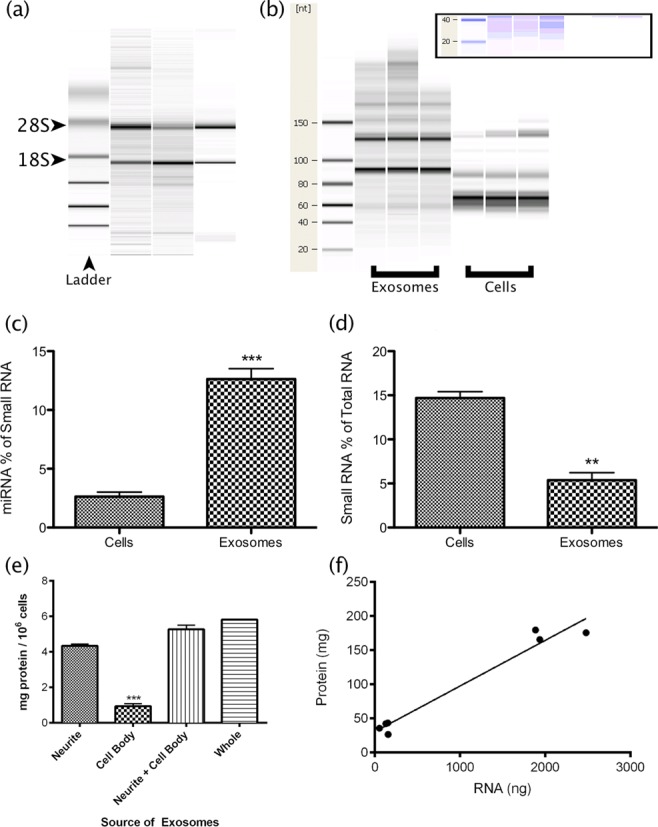
Vesicular nucleic acid composition is consistent with exosomes. (a) Bioanalyzer analysis of triplicate samples revealed the presence ribosomal RNA. (b) Bioanalyzer comparison of small RNAs derived from vesicles and cells. The vesicular samples appeared enriched for small RNAs (inset). (a and b) Lanes represent individual samples. (c) Quantitative analysis of Bioanalyzer data confirmed that miRNA comprised a significantly greater proportion of small RNA in the vesicles, despite (d) a reduced overall contribution of small RNA to total RNA. (e) Neurites and cell bodies were separated prior to depolarization. Quantitation of protein from vesicle fractions obtained indicated that the neurites are the primary source of depolarization-associated vesicle release. (f) Correlation of protein and RNA yields from neurite- and cell body-derived vesicles (R2 = 0.96).